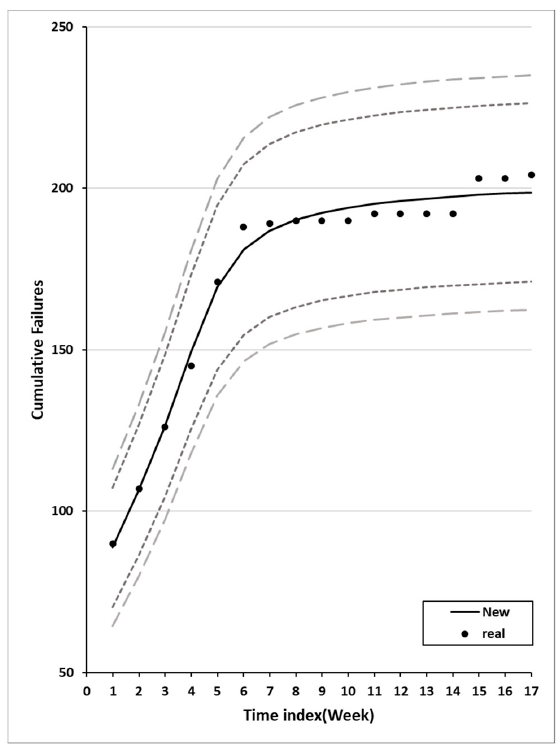
Figure 6. Actual data and estimated mean value function and confidence limits of the proposed model for Dataset #2.